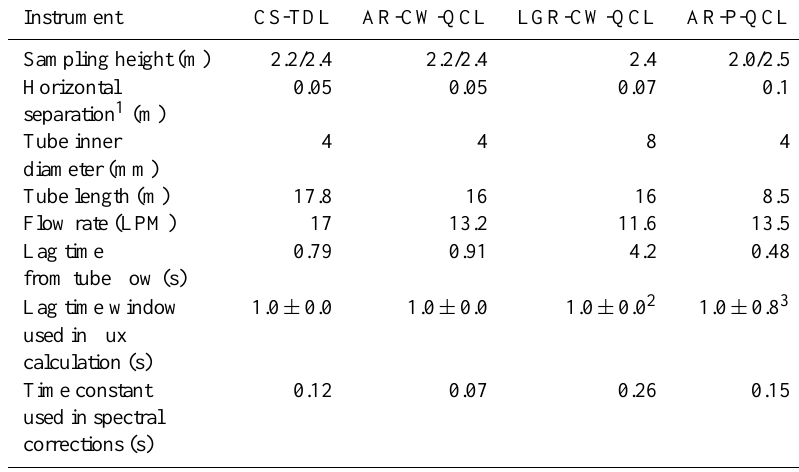
Table 2. Eddy covariance measurement set-up, flux calculation and quality screening parameters.